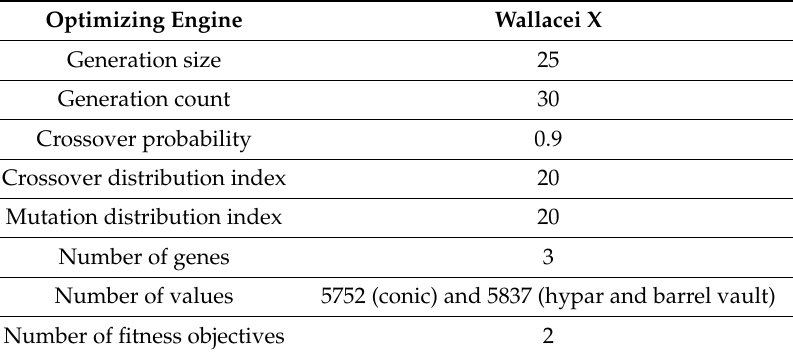
Table 1. Optimizing